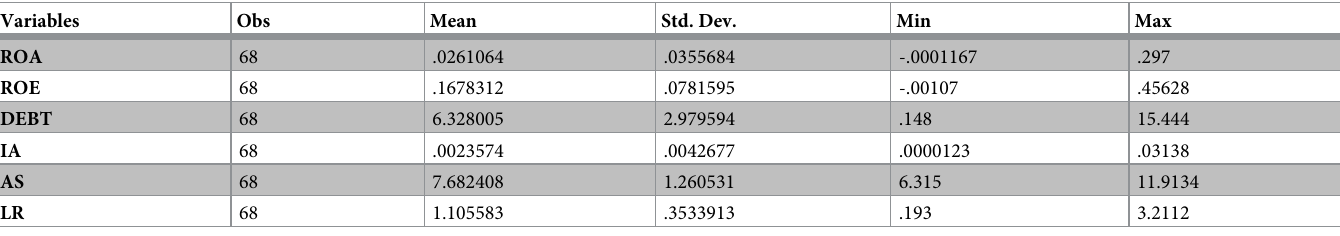
Table 2. Descriptive statistics of the